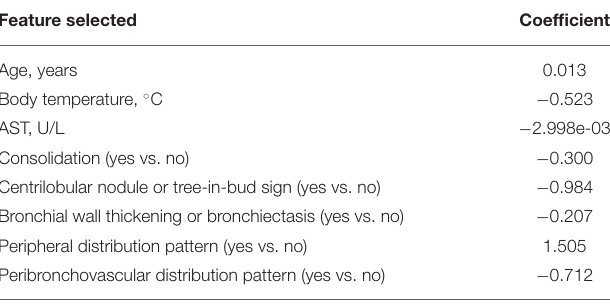
TABLE 3 | The coefficients of the elected features by LASSO logistic regression analysis. Feature selected